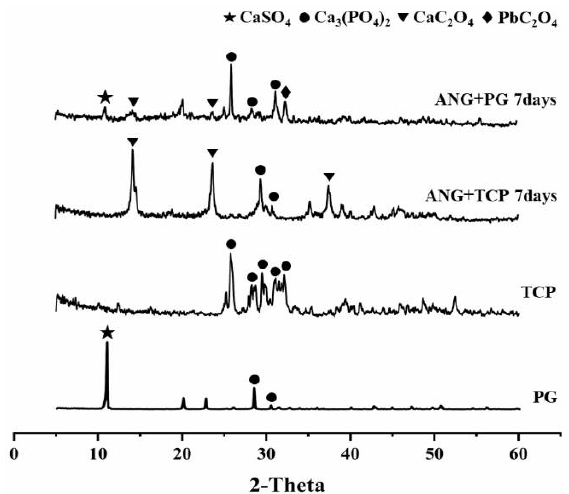
Figure 4. XRD patterns of the precipitation in ANG + TCP and ANG + PG treatments after 7 days of incubation. The patterns on the bottom are standard TCP and PG minerals.